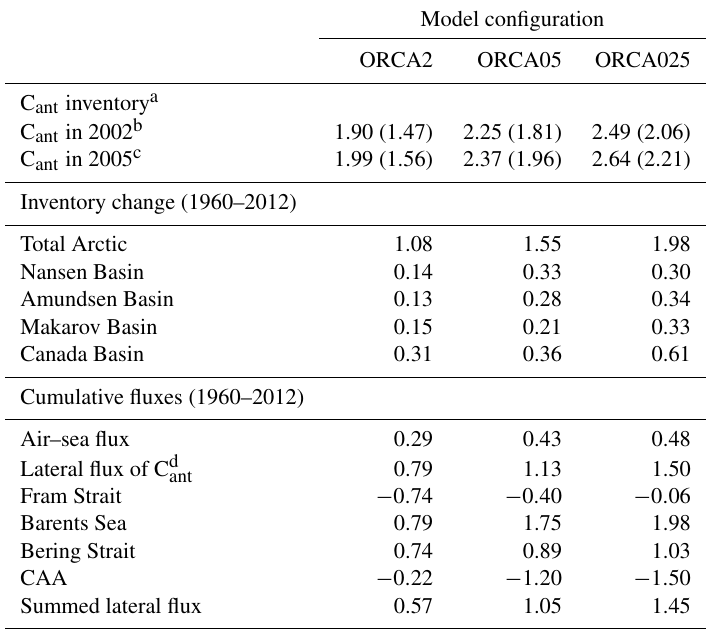
Table 6. Total inventory, its change during 1960–2012, the cumulative air–sea flux, and the lateral flux of C ant in PgC.